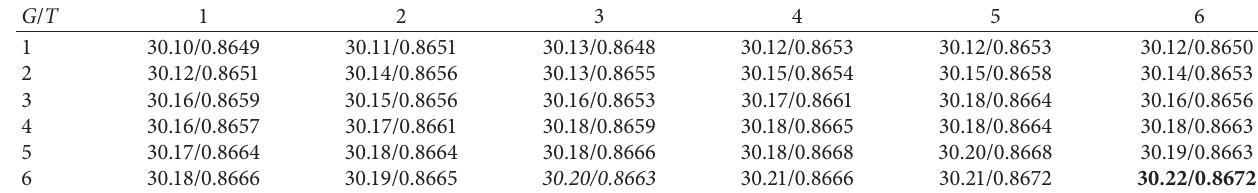
Table 6: The performances (PSNR/SSIM) under different G and T on DSLR-based City100 database ( L � 5 and R � 4 fixed). G / T 1